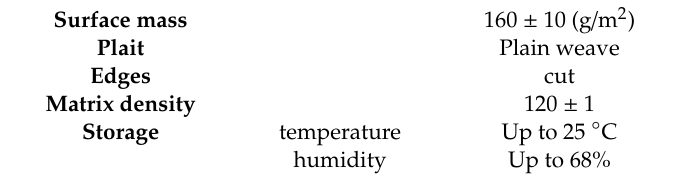
Table 4. Properties of used glass fiber.